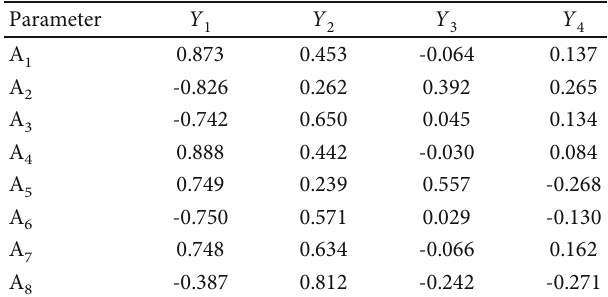
Figure 2: Cumulative contribution rates of all principal components. Table 4: PCA matrix.